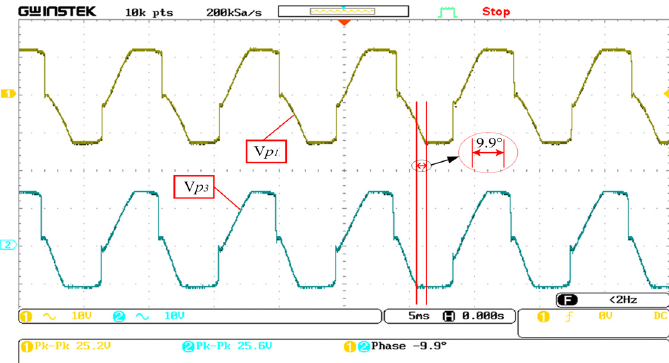
Figure 10. Phase difference between V p 1 and V p 3.